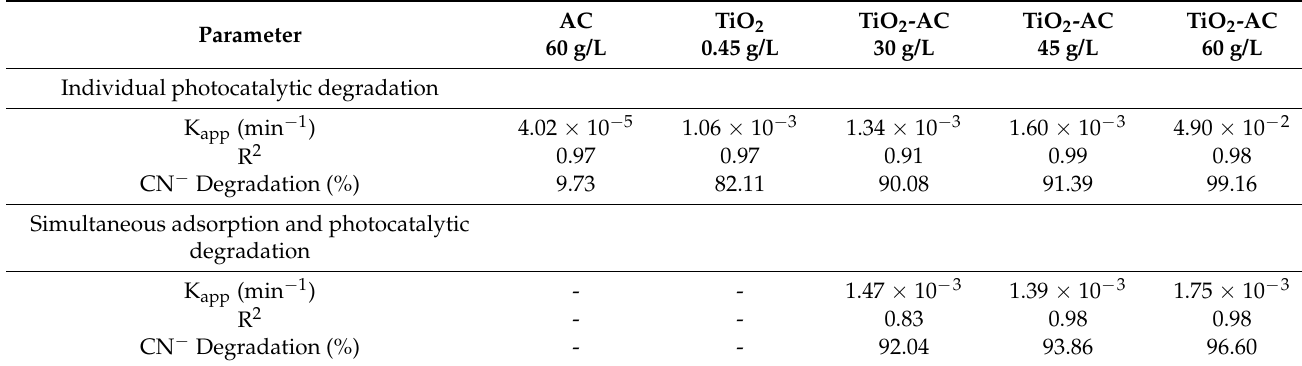
Table 5. Kinetic model results in cyanide ion